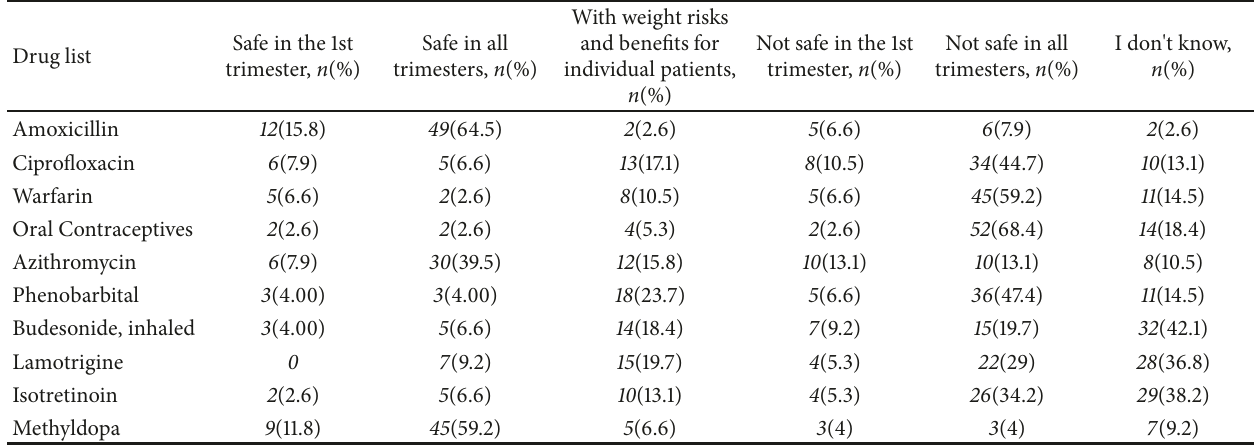
Table 2: Results of medication safety during pregnancy test for pharmacy professionals (POM).